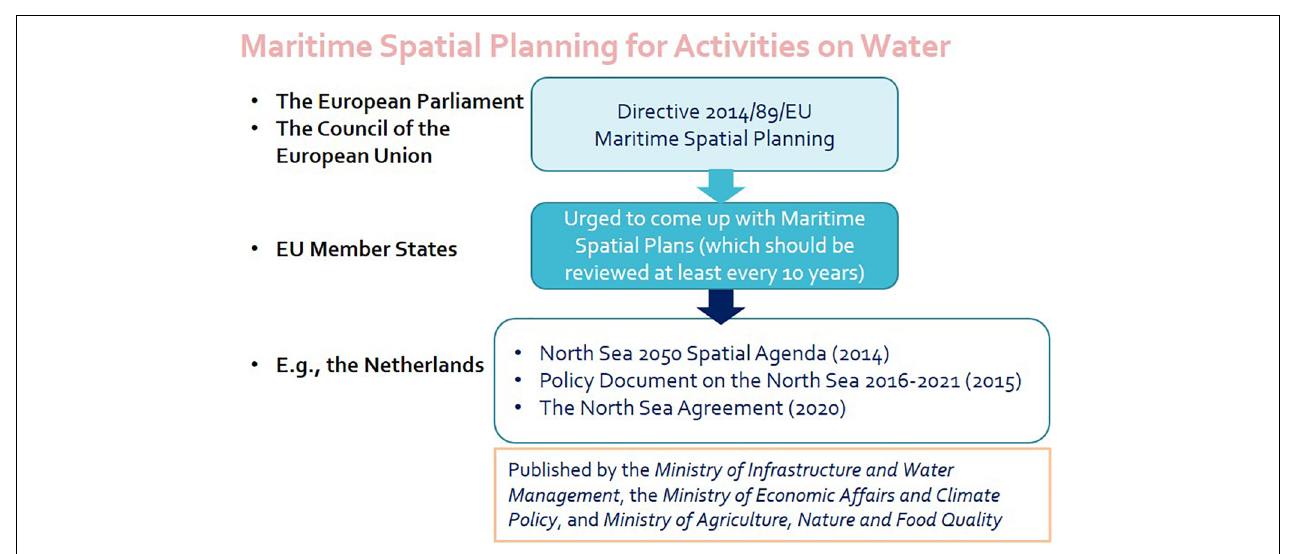
FIGURE 3 | Maritime spatial planning for activities on water, giving the example of the Netherlands. One may be curious about the types of floating development have been included in these documents, and whether floating for living purpose was one of them. In the North Sea 2050 Spatial Agenda, floating constructions at sea for harvesting tidal and wave energy were included in the wind energy areas as a long-term energy solution since it is believed that combining energy generation technologies will offer financial, logistical, and spatial opportunities. What is also interesting to note is that a group of primary school students were asked by the Ministry of Infrastructure and Water Management to think about the future of the North Sea. One of the ideas that the students came up with was to introduce “floating hotels” to the North Sea, showing that our next generation seemed to consider living on water a possible activity in the North Sea in the